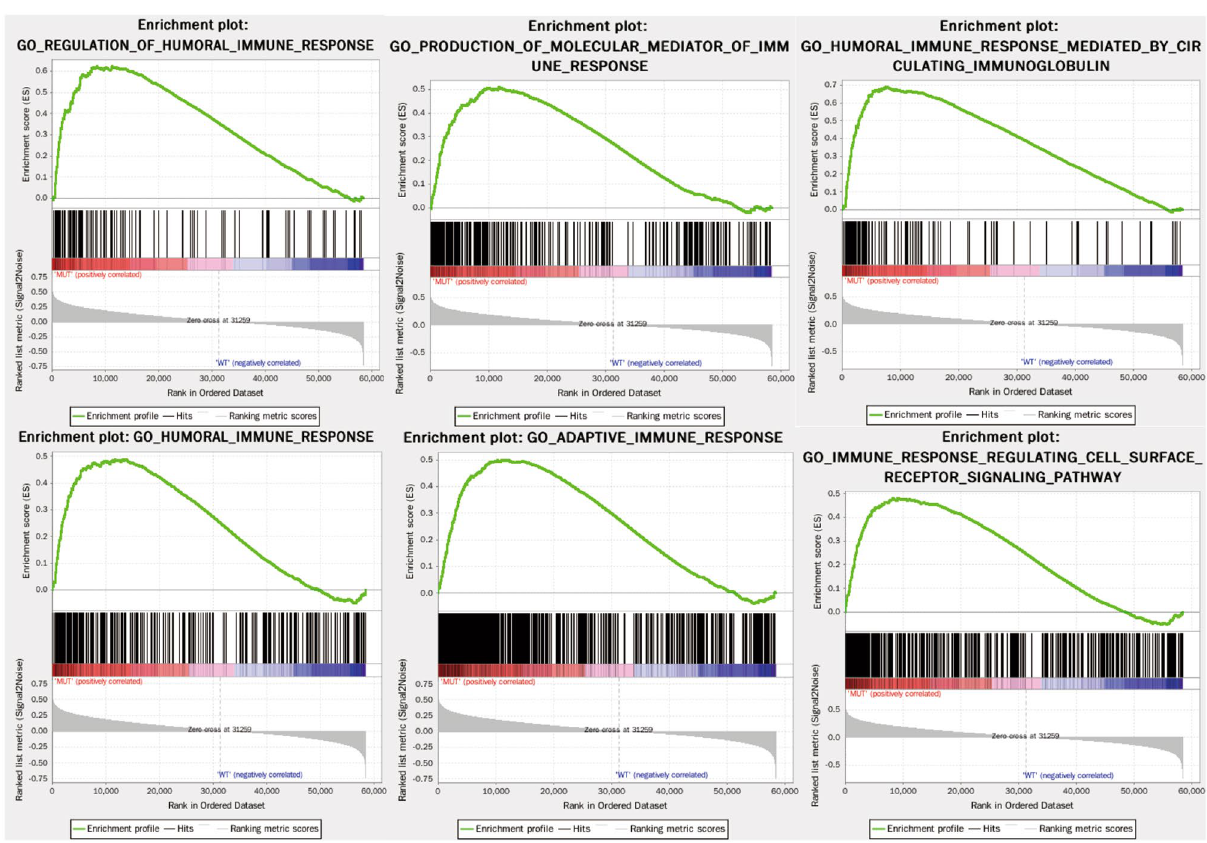
Figure 1. Comparison between significantly enriched immune-related phenotypes in the patients of the MUT and WT groups based on GSEA